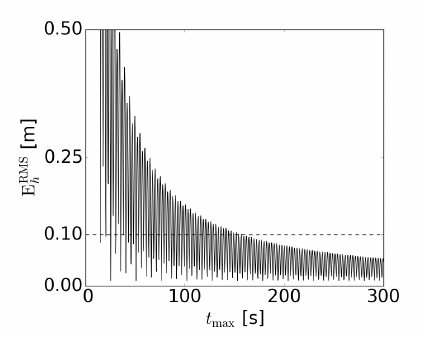
Figure 4. Evolution of the Root Mean Square (RMS) error in h , E RMS monochromatic case using phase fitting (without